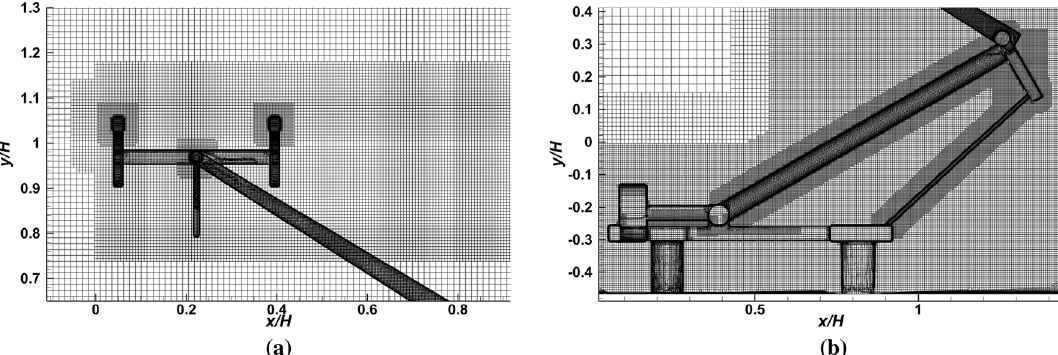
Fig. 14 a Mesh around the raised pantograph frame and b mesh around the panhead